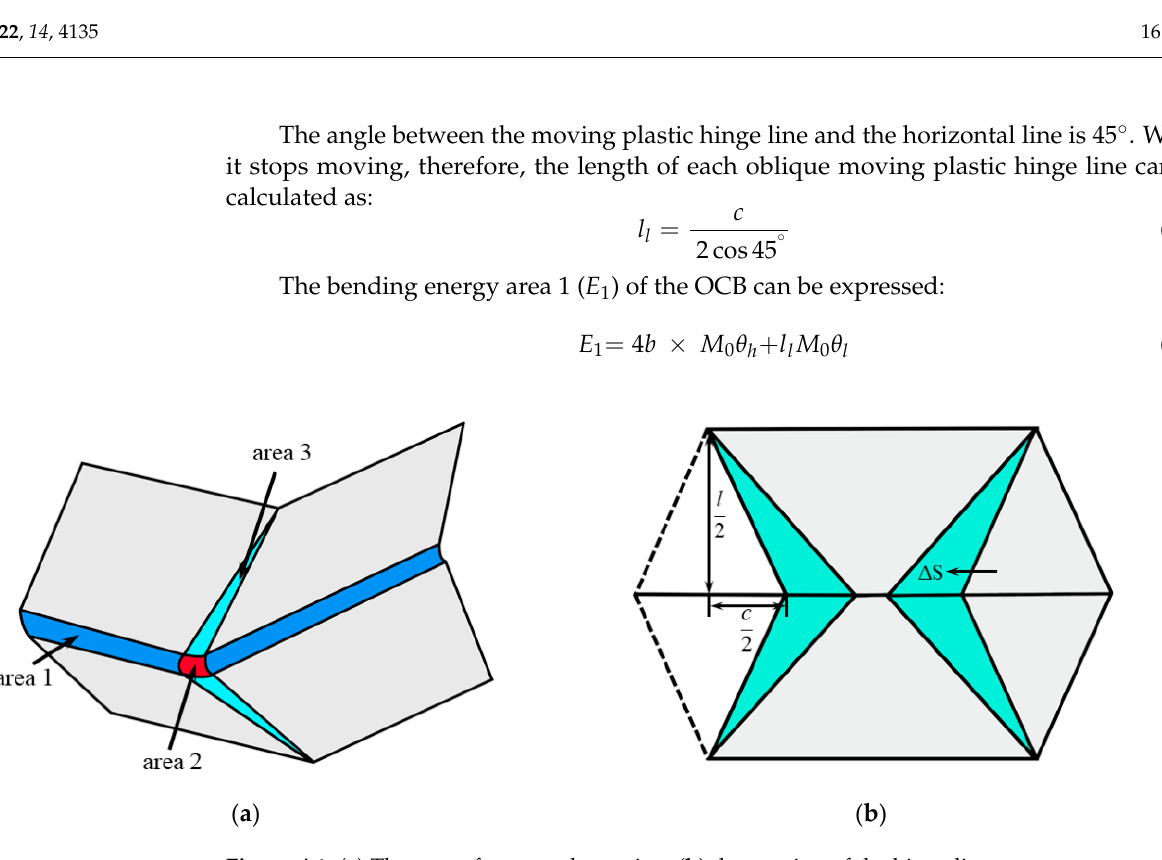
Figure A1. ( a ) The area of energy absorption; ( b ) the moving of the hinge lines.